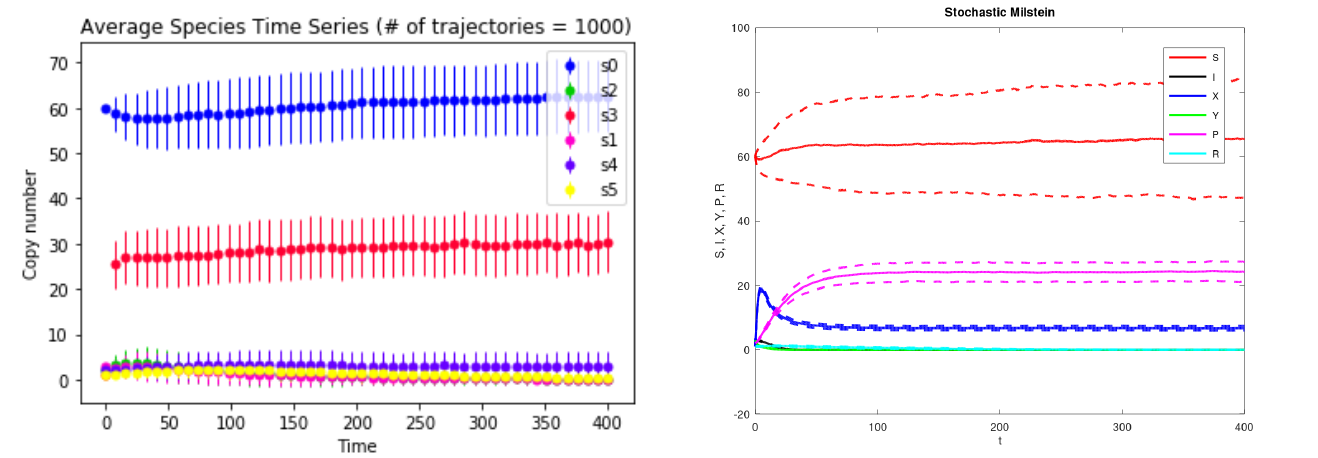
Figure 7. Plots for virus plant models with saturation and no delays. ( Left ) SSA; the vertical lines denote the inter- vals (mean − 1 standard deviation, mean + 1 standard deviation). ( Right ) Stochastic differential equations simulation— mean values (solid lines) and mean values +/ − 1 standard deviation (dashed